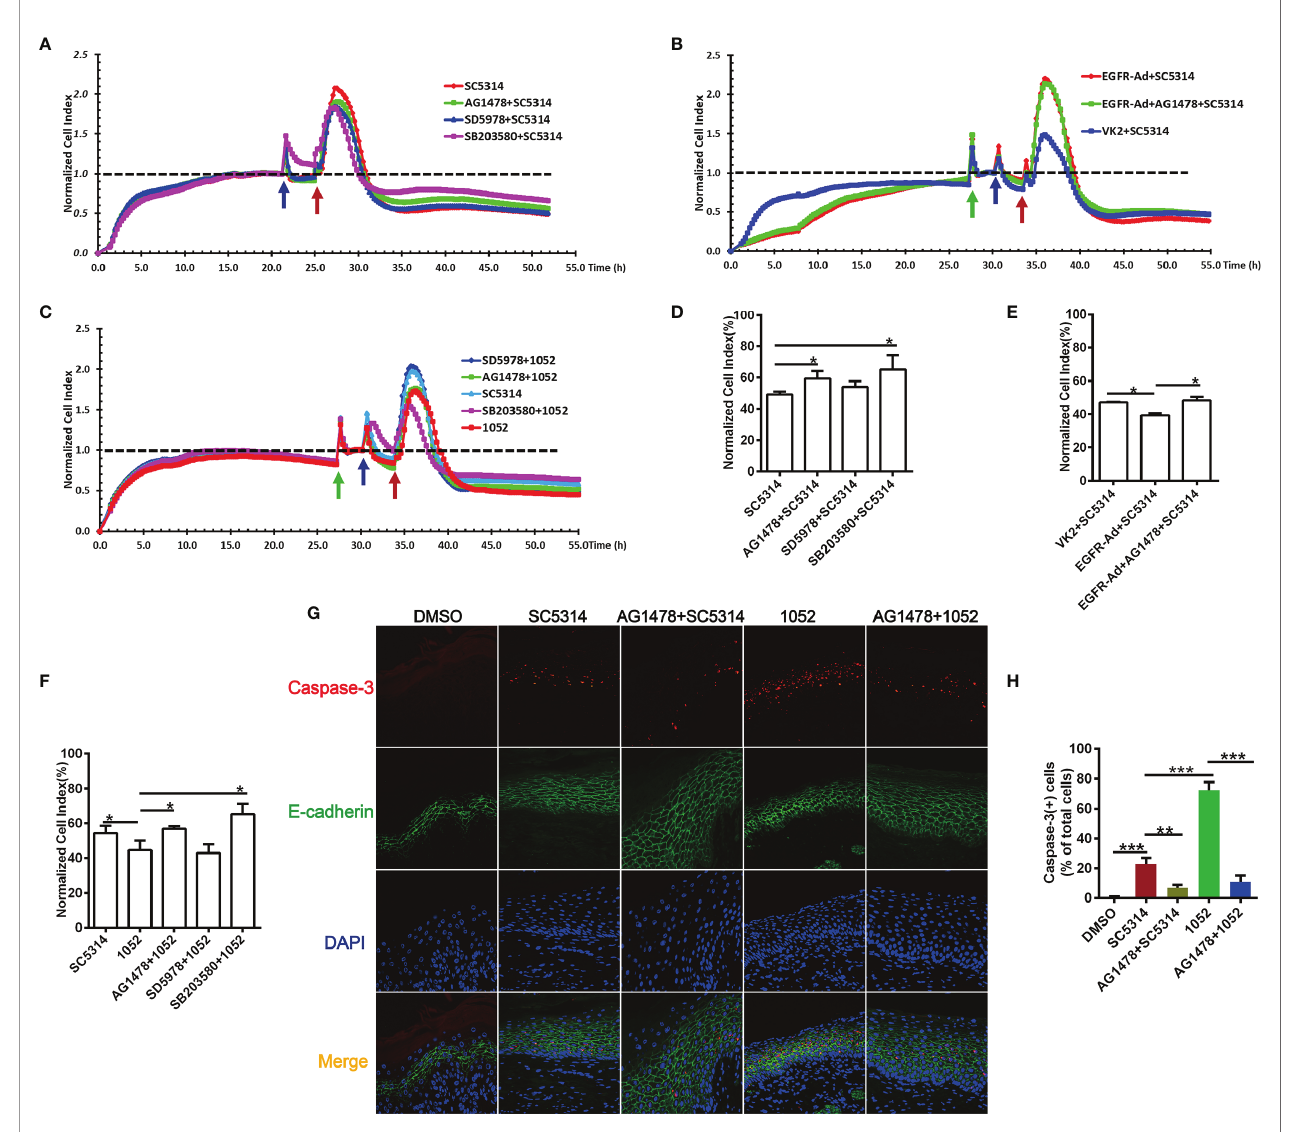
FIGURE 5 | EGFR and MAPK signaling regulate the viability of vaginal epithelial cells after infection with C. albicans. Cell damage was monitored continuously by xCELLigence Real-Time Cellular Analysis (RTCA) system. Normalized Cell Index (NCI) demonstrated cell viability. 1052-infected VK2/E6E7 cells exhibited a signi fi cant decrease in viability when compared to SC5314 infections and pre-treatment of the EGFR and p38 inhibitors protected cells against SC5314 or 1052-killing (A, C) . SC5314-infected EGFR-Ad cells exhibited increased damage when compared to the infected VK2/E6E7 cells (B) . NCI at 24 h post infection in graph (D – F) provides the mean cell viability. Green arrow represents the time points on which the medium was changed. Blue and red arrows represent the time point at which inhibitors and Candida strains were added into the well respectively. VVC mice were treated as previously ( Figure 1D ). Immuno fl uorescent staining of E-cadherin (green), caspase-3(red) and DAPI (blue) demonstrated apoptotic vaginal epithelial cells in vaginal tissues sections (G) . Numbers in graph (H) provide the mean apoptotic vaginal epithelial cells count per group (n=3/each group). Data are representative of three independent experiments. Error bars represent SD, *p < 0.05, Error bars represent SD, *p < 0.05, **p < 0.01, ***p <